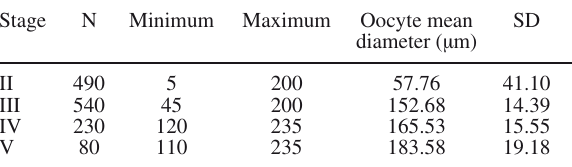
Fig . 5. – Maturity stages of H. sanctori at Gran Canaria from Febru- ary 2009 to January 2011. Table 2. – Mean oocyte diameter for stages of maturity II, III, IV and V of H. sanctori at Gran